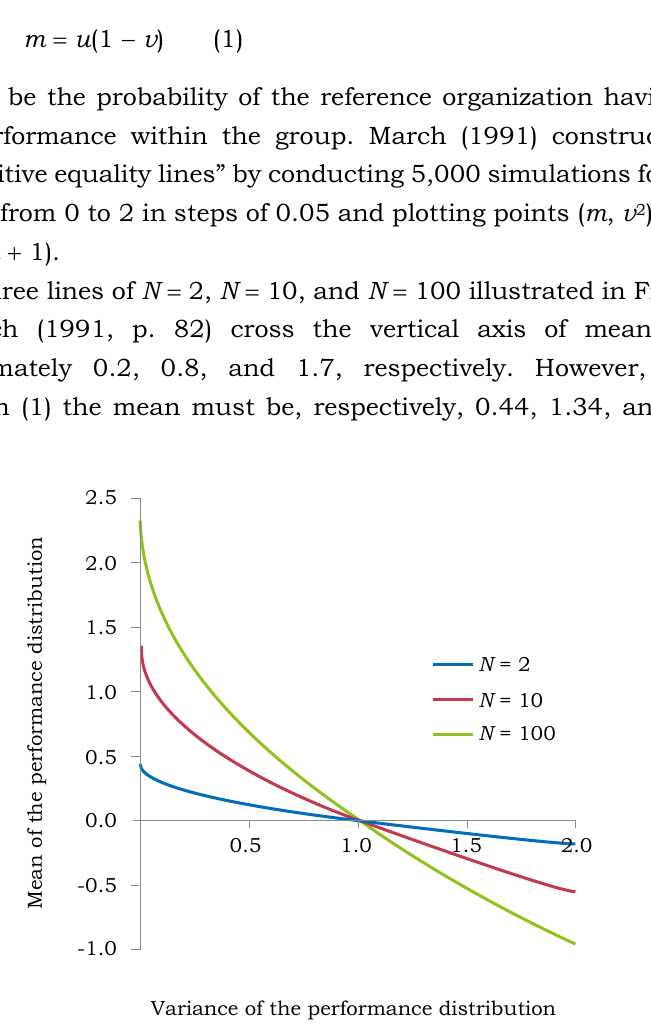
normal distribution table ( u  0.44 for N  2, u  1.34 for N  10, u  2.33 for N  100), Takahashi (1998) obtains the following equation: